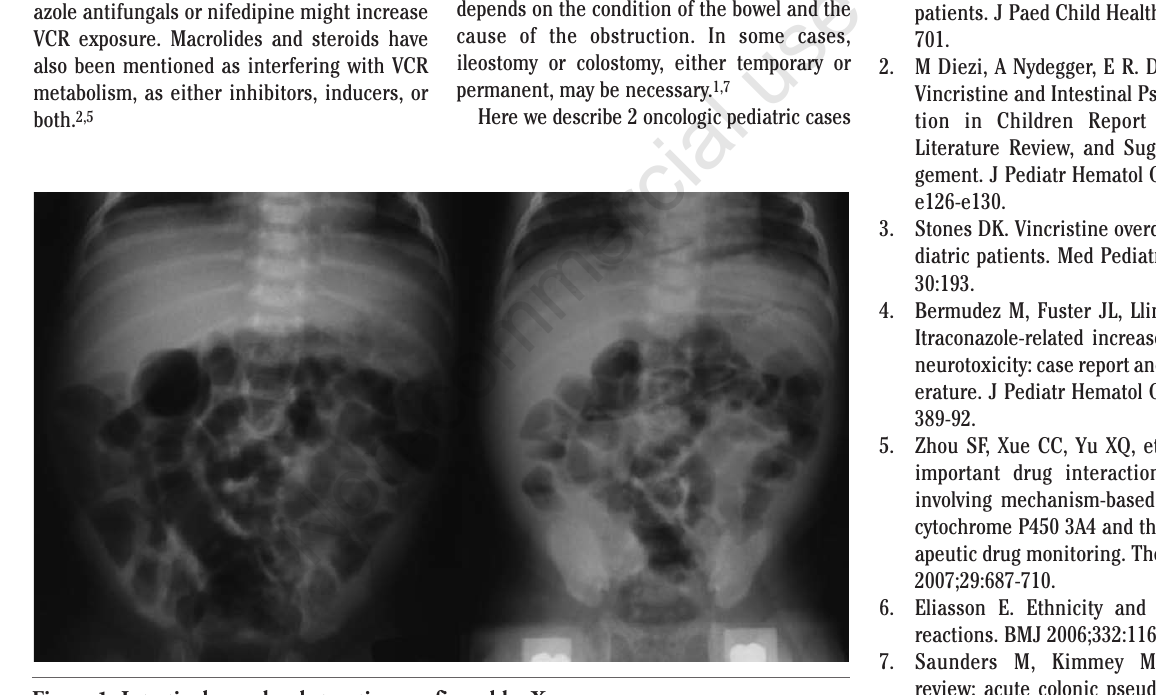
Figure 1. Intestinal pseudo-obstruction confirmed by